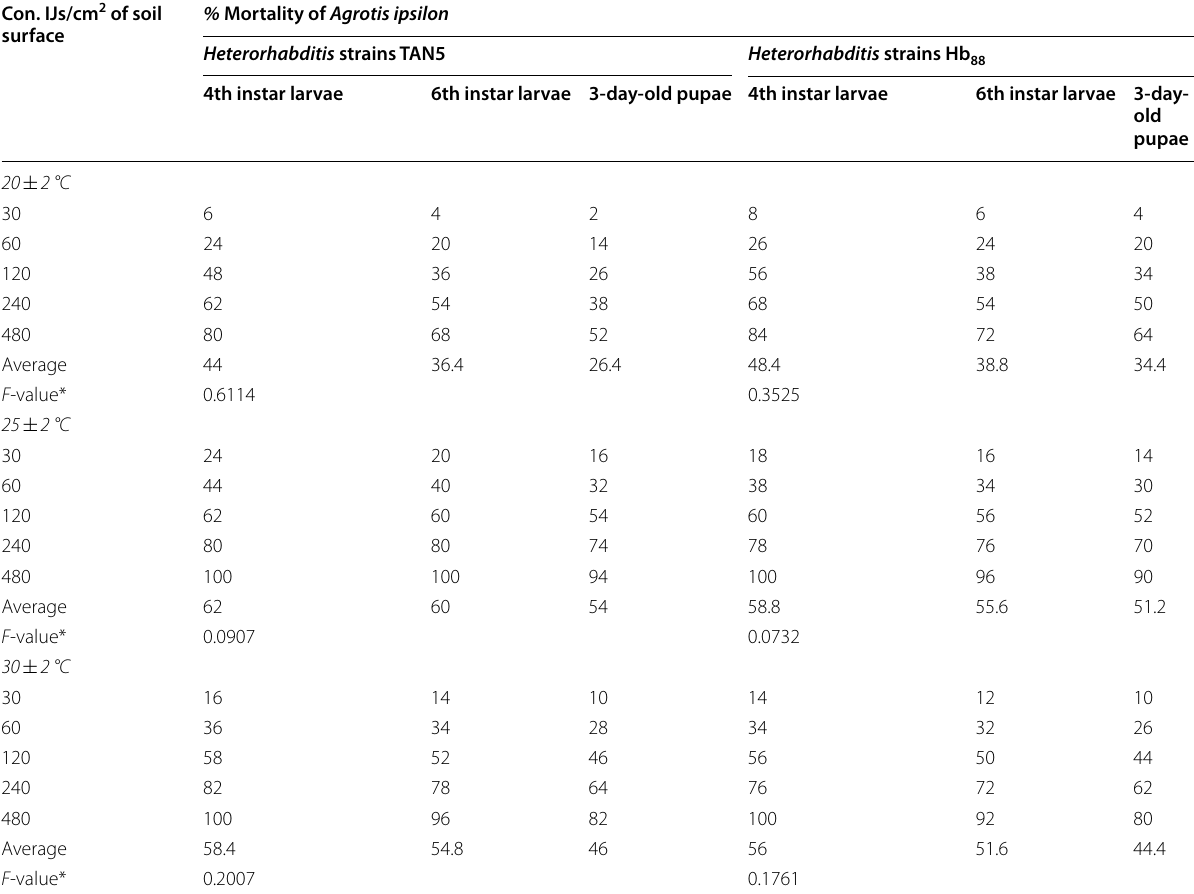
at temperature 20, 25, and 30 2°C and water content in the soil 20% 88 ±